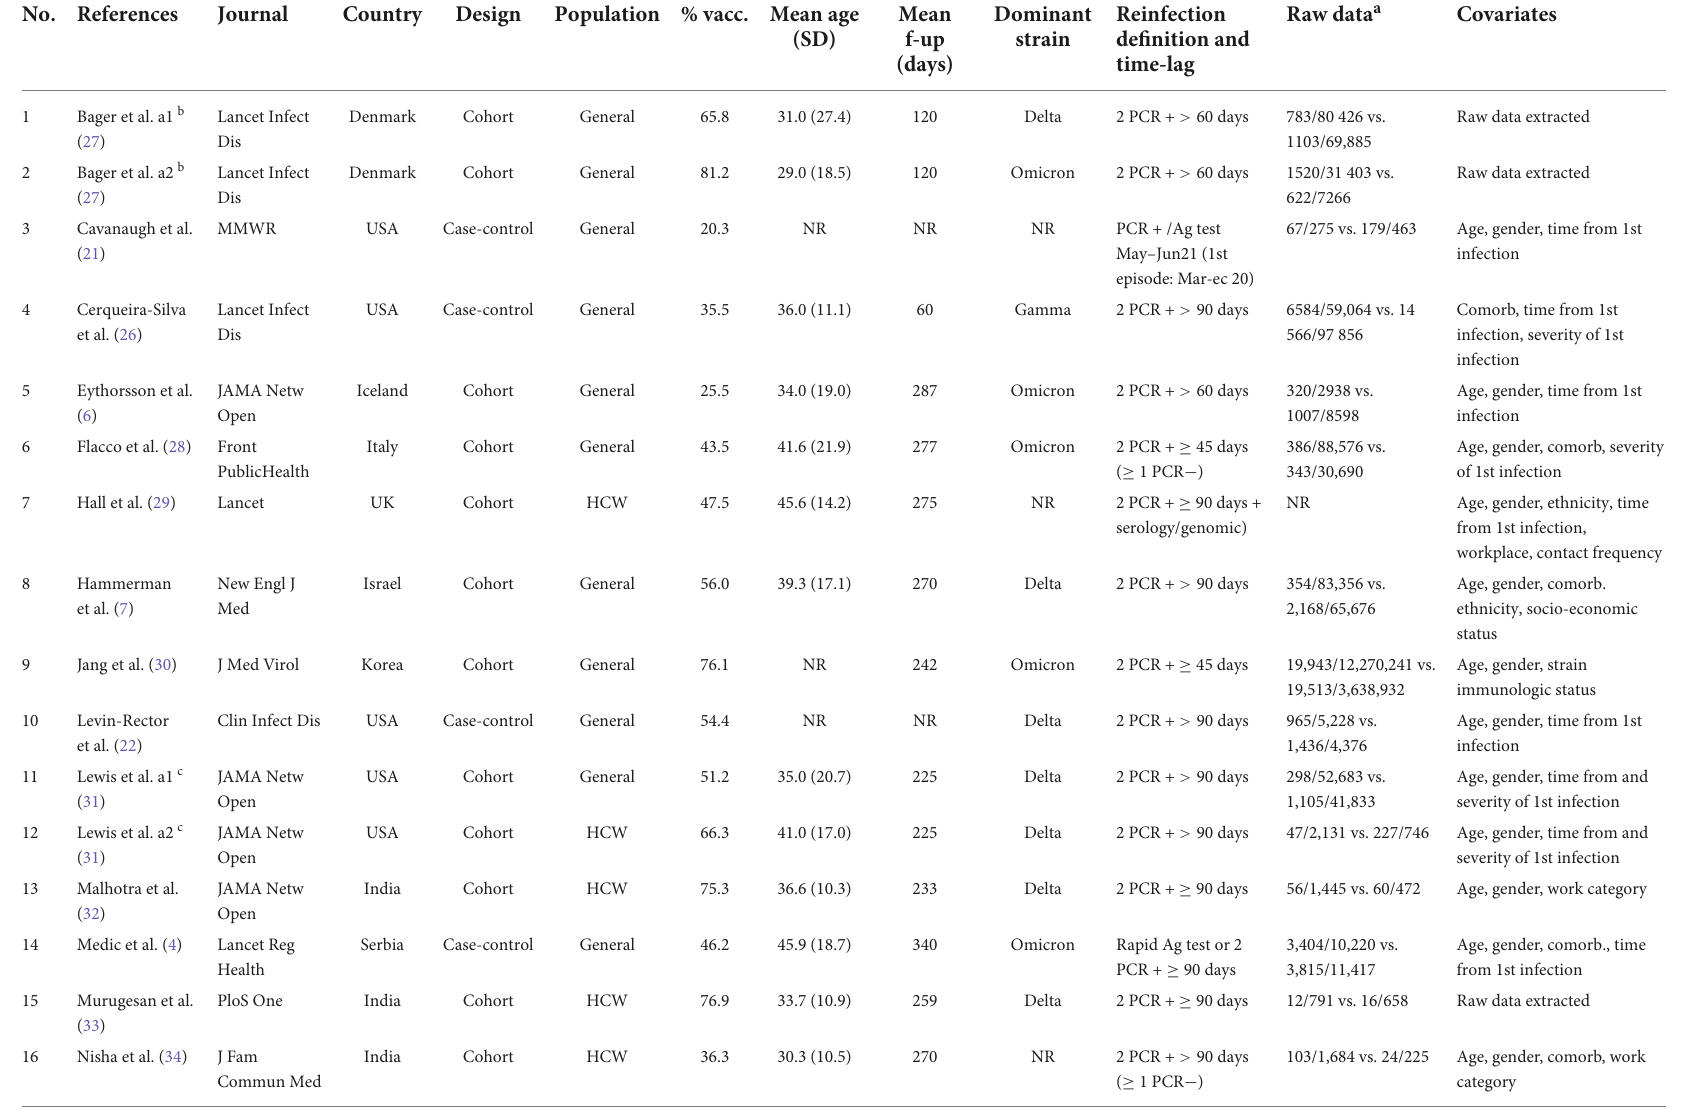
TABLE 1 Characteristics of the included